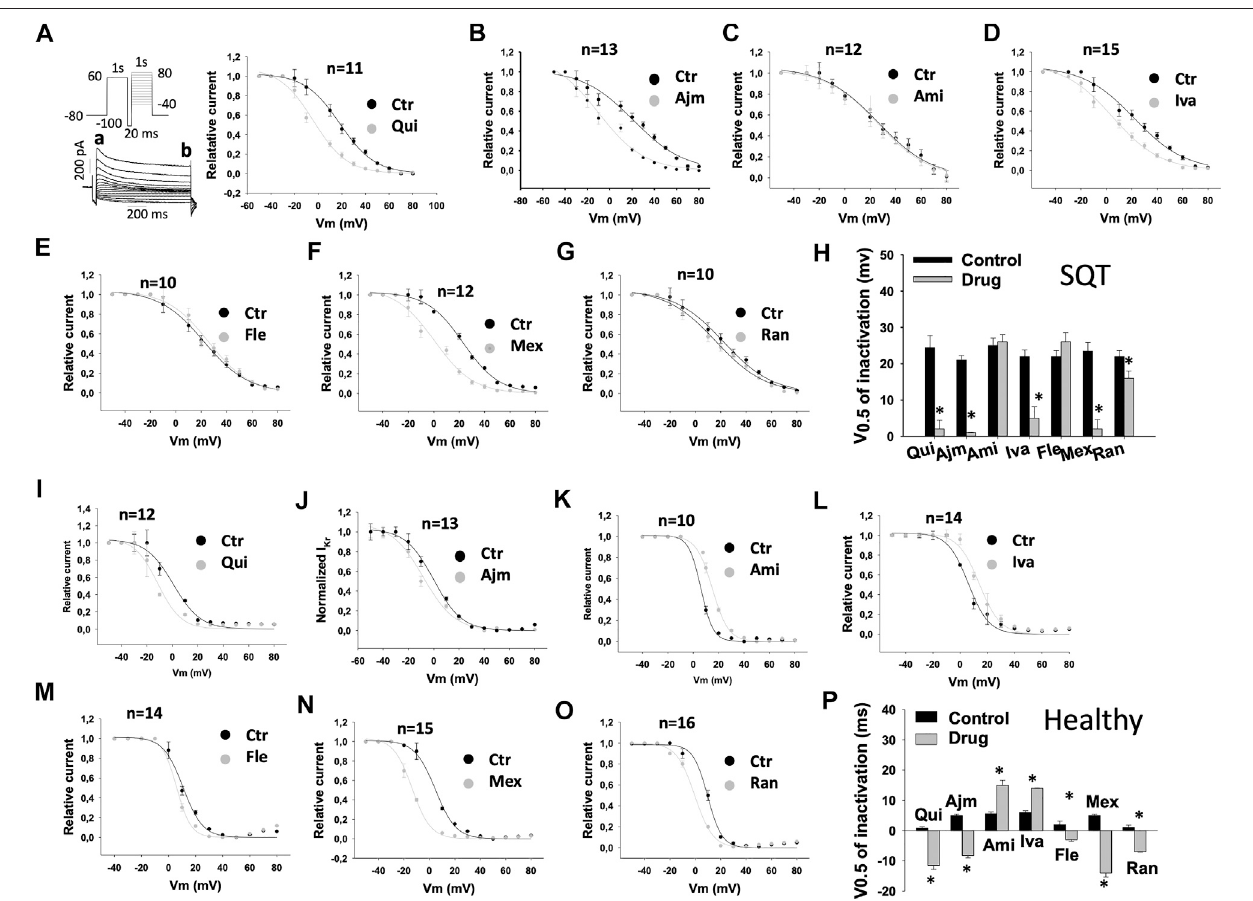
FIGURE4| Drugeffectsonvoltage-dependentinactivationofI Kr inSQTS1-hiPSC-CMs.I Kr wasevokedbytheprotocolshowninA (rightpanel) .Apre-pulseof1 s from − 80 mV (the holding potential) to +60 mV followed by a short (20 ms) repolarization to − 100 mV was given for channel activation, inactivation and recovery of inactivated channels to open state. Before deactivation occurs, test pulses of 1 ° s from − 50 to +80 mV (10 mV increments) were started to evaluate the inactivation of channels. I Kr was measured at the beginning (peak current, a) and end (steady current, b) of test pulses as shown in A (right panel) . The currents in same cells before and after application of a drug were measured. The current of inactivated channels (I inact ) was calculated as: I inact (cid:1) Ia-Ib, where Ia is the peak current, Ib is the steadycurrent. WhenI inact islargerthan zero,itmeansinactivationoccurred.WhenI inact equals orissmallerthan zero,itmeansnoinactivationoccurred.I inact at different potentials were measured and normalized to the maximal current (I inactMax ). To plot the inactivation curves as usually shown (the curve decays with increasing voltages), the relative current was calculated by I (cid:1) 1 − I inact /I inactMax . Finally, I was normalized to the maximal value I max and plotted against voltages to obtain an inactivation curve. The inactivation curves were then fi tted by Boltzmann equation to obtain the voltage value at half maximal inactivation (V0.5). (A – G) Inactivation curves of I Kr in